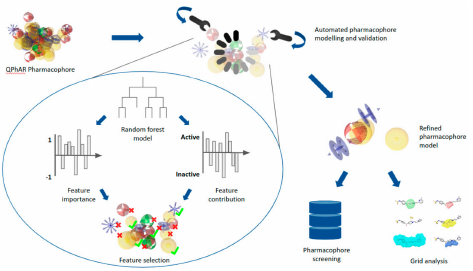
Figure 2. Schematic depiction of end-to-end pharmacophore modelling